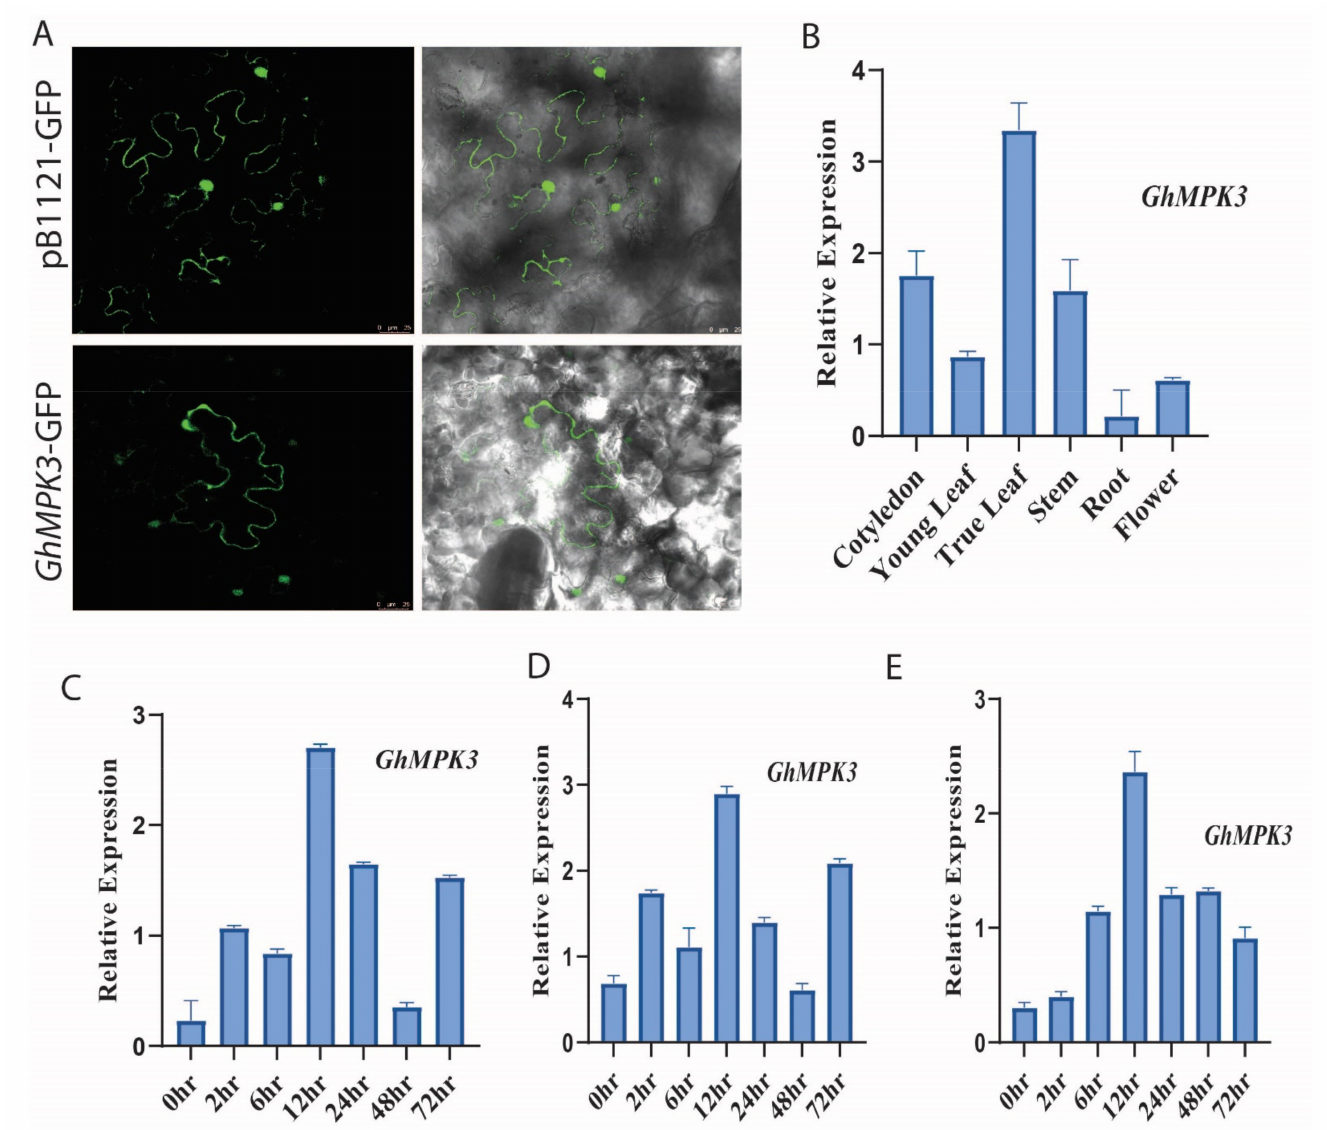
Figure 2. GhMPK3 -GFP analysis in Nicotiana benthamiana and expression level in cotton. ( A ) GhMPK3 -GFP analysis. ( B ) GhMPK3 TM-1 tissue expression level. ( C ) GhMPK3 expression pattern under cold stress. ( D ) GhMPK3 expression pattern under drought stress. ( E ) GhMPK3 expression pattern under salt stress. The standard deviation of three replications is reflected by error